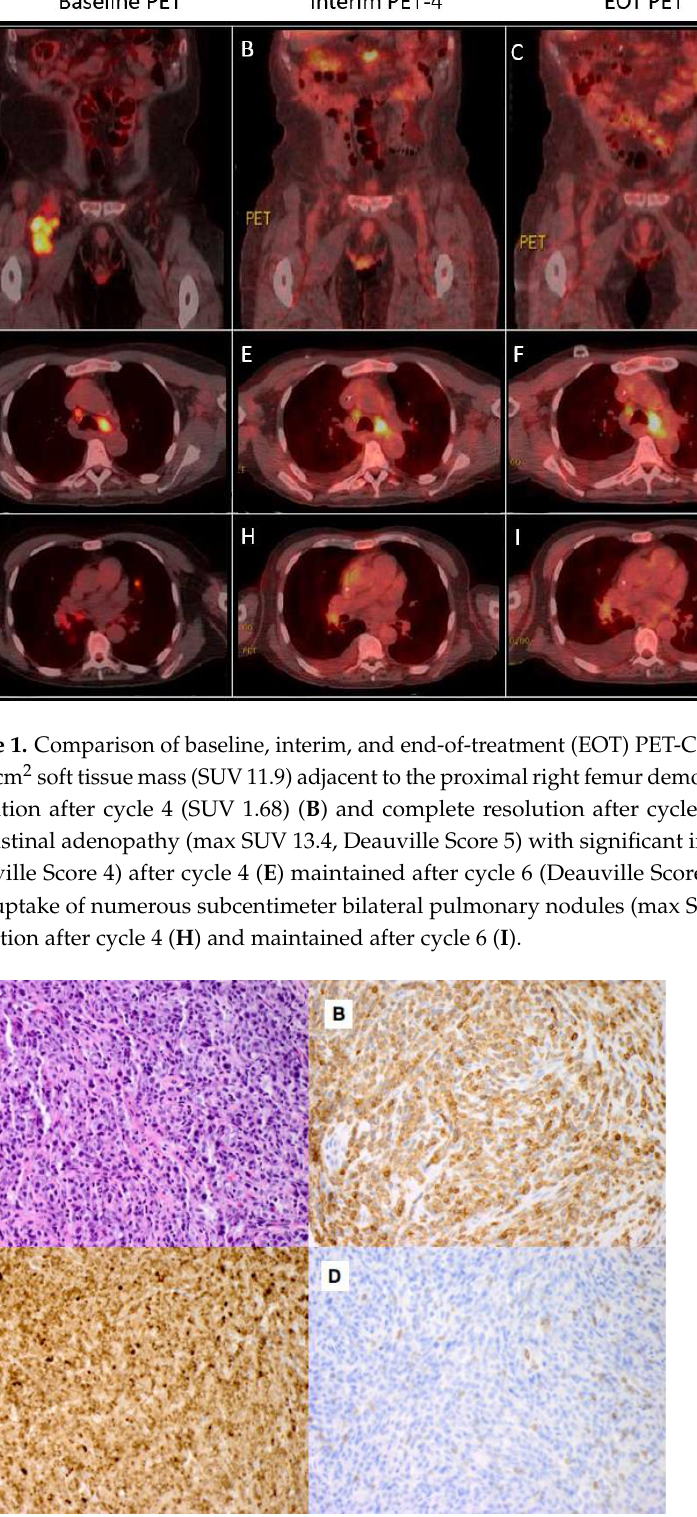
Figure 2. Histologic morphology and immunohistochemical stains on the soft tissue mass. ( A ) The tumor shows a diffuse infiltration of large, atypical lymphocytes in a fibrohistiocytic background (Hematoxylin and Eosin ×400). The lymphoma cells express CD3 ( B ), CD30 (30% of lymphocytes) ( C ) and are negative for CD5 (×400) ( D ). At the time of the PTLD diagnosis, IS therapy consisted only of tacrolimus 1 mg twice daily. After discussion with the transplant team, the tacrolimus dose was decreased to 0.5 mg twice daily, and CHOP-21 chemotherapy was initiated. However, based on the emerg- ing ECHELON-2 outcomes with the addition of brentuximab vedotin (BV) to an anthracy- cline-based chemotherapy backbone in CD30-positive PTCL, after two cycles of CHOP, the patient’s chemotherapy regimen was changed to BV-CHP [10–12]. BV was dosed at 1.8 mg/kg with CHP every 3 weeks with G-CSF support, according to the published ECHELON-2 regimen [9,10]. Cycle 3 (BV-CHP #1) was complicated by neutropenic sepsis, and BV was reduced to 1.3 mg/kg for cycles 4–6. Cycle 4 (BV-CHP #2) was again compli- cated by neutropenic sepsis, and cyclophosphamide and doxorubicin dosing were re- duced by 25% for the remaining cycles 5 and 6. Interim PET-CT after cycle 4 showed a complete resolution of previously seen pulmonary metastases, a decrease in the medias- tinal (1.3 cm, max SUV 9.3; from pre-treatment 1.6 cm, max SUV 13.4) and hilar adenopa- thy, and a near complete resolution of the soft tissue mass in the right anterior thigh (2.4 × 2.3 cm 2 , max SUV 1.68, from pre-treatment 5.8 × 3.9 cm 2 , max SUV 11.9), overall con- sistent with a partial response (PR). End-of-treatment PET-CT after cycle 6 showed stable disease in the mediastinal (1.3 cm, max SUV 10.25) and hilar adenopathy, and no new or recurrent adenopathy, with complete resolution of the previously seen right lower ex- tremity soft tissue mass, consistent with ongoing PR (Figure 1). Maintenance therapy with single-agent BV was discussed and started, but after one BV maintenance dose he was again admitted with a neutropenic febrile episode and the patient requested to stop all therapy, as he was satisfied with the achieved response. Following completion of front-line therapy, his course was complicated by elevations of alkaline phosphatase (peak 417 U/L 3 months post-treatment initiation, from pre-treat- ment 97 U/L) and AST (peak 75 U/L 11 months post-treatment initiation, from pre-treat- ment 33 U/L) levels. ALT remained within normal limits. A liver biopsy completed 8 months after treatment initiation showed minimal lobular inflammation, but no evidence